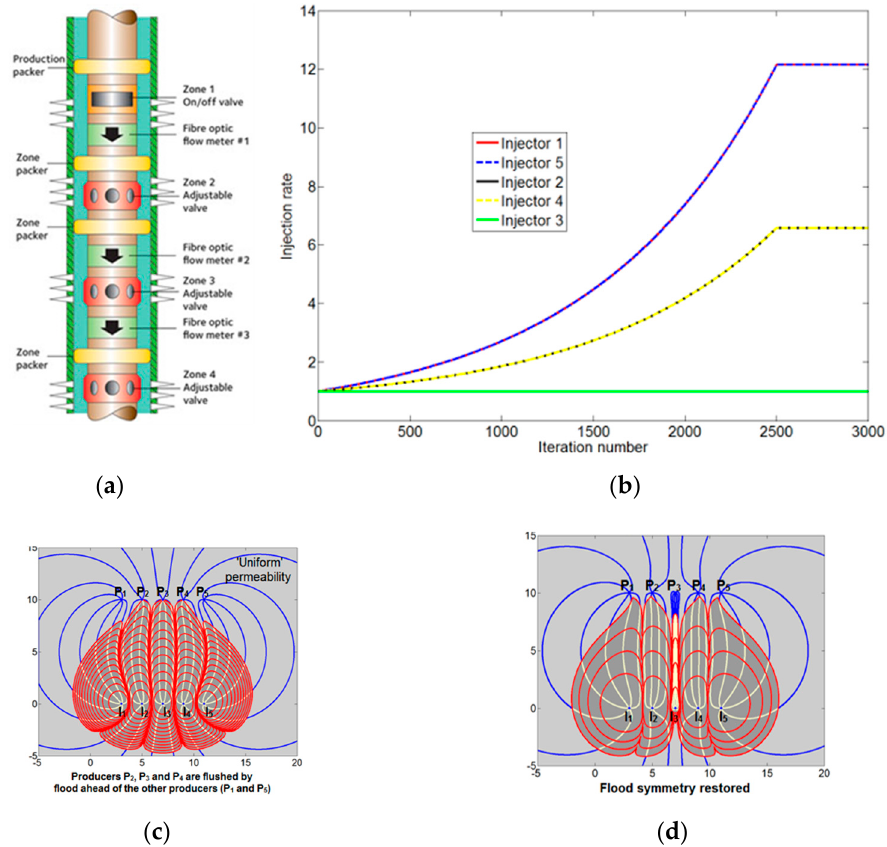
Figure 7. Closed-loop optimization of sweep efficiency using CAM. ( a ) Example of Inflow Control Valves (ICVs) with hydraulically operated sliding sleeves and flow meters such as first used in 2004 (for injection well A-11B at Statoil’s Veslefrikk Field, North Sea). ( b ) Injection rates (non-dimensional) of wells I 1 to I 5 are iteratively adjusted by pressure monitoring of producer wells image ( c ) to achieve optimized sweep efficiency with equal flood arrival time at the producers as in ( d ). Reproduced with permission from [26].